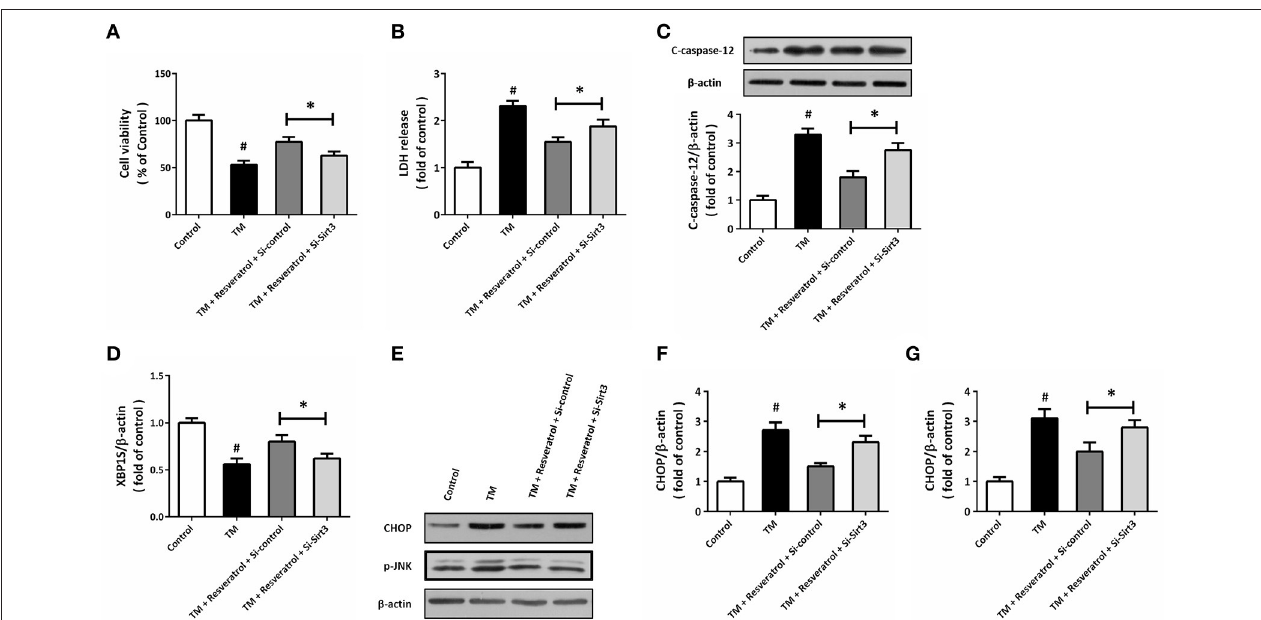
FIGURE 7 | Knockdown of Sirt3 partially prevents resveratrol-induced protection. HT22 cells were transfected with Si-control or Si-Sirt3 for 48h, and treated with TM in the presence or absence of resveratrol for another 24h. Cell viability was measured by MTT assay (A) , and cytotoxicity was determined by LDH assay (B) . The expression of cleaved-caspase-12 was detected by western blot (C) . The mRNA levels of XBP1S was examined by RT-PCR (D) . The expression of CHOP, p-JNK, and cleaved-caspase-12 was detected by western blot (E–G) . Data are shown as mean ± SEM. # p < 0.05 vs. Control. * p <